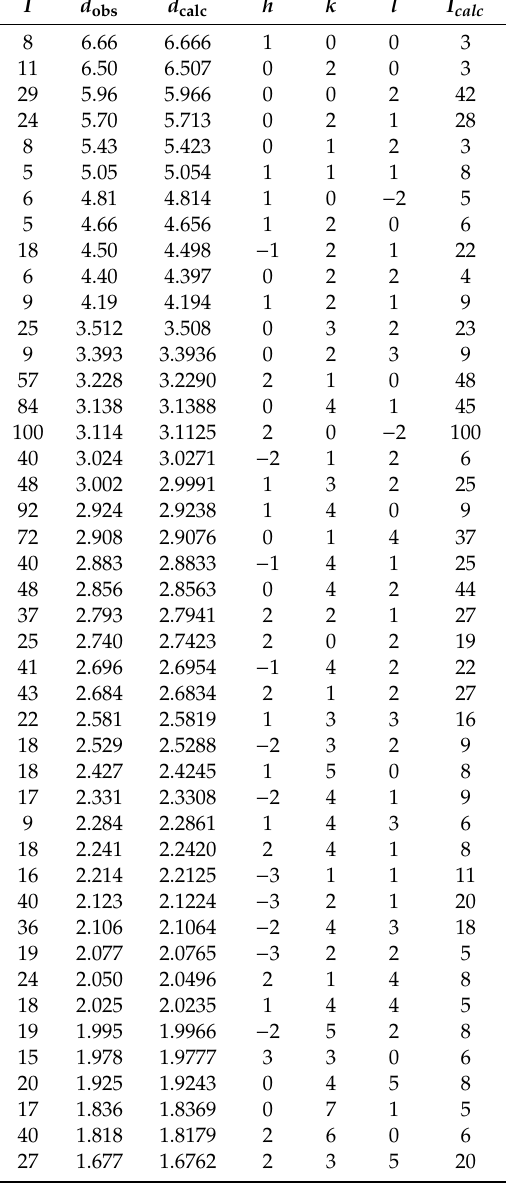
Table 4. X-ray powder di ff raction data ( d in Å) for